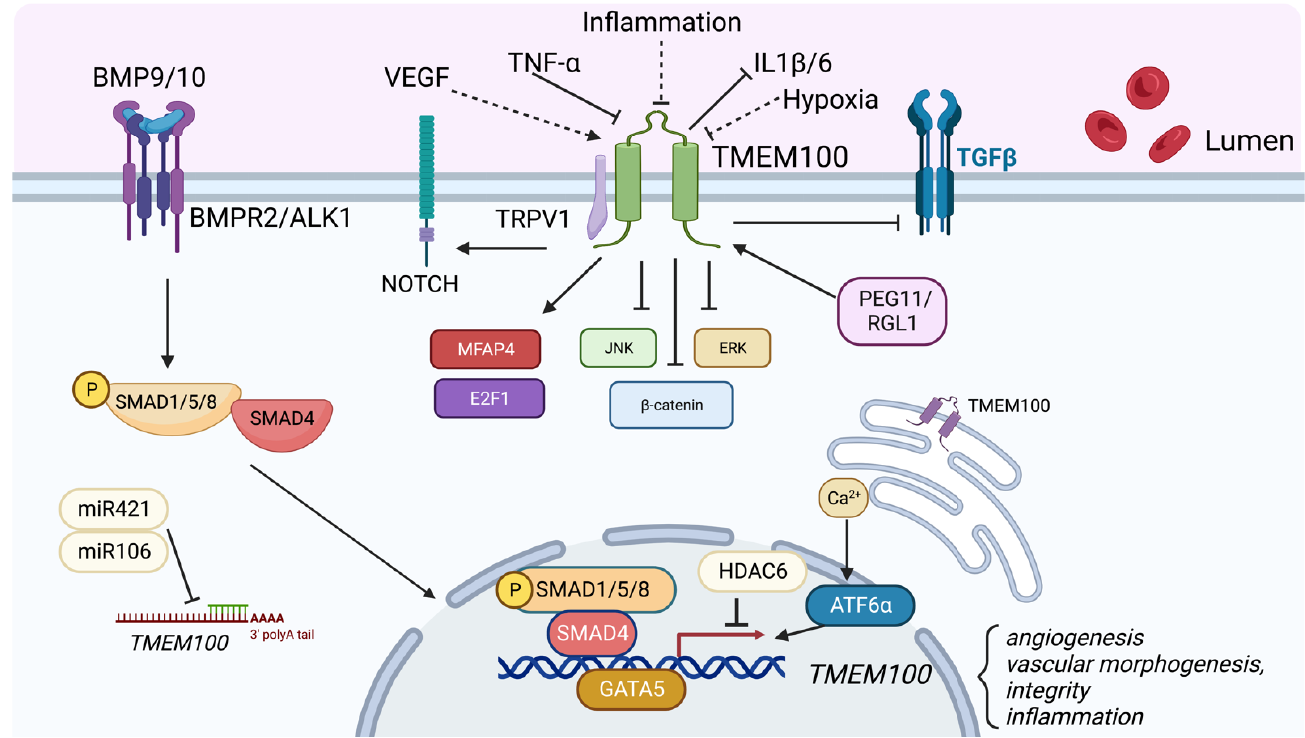
Figure 2. Role of TMEM100. TMEM100 is a two transmembrane protein located in the plasma membrane and endoplasmic reticulum membrane. TMEM100 is a BMP9/10-BMPR2/ALK1-pSMAD1/5/8 signaling downstream target. Various factors such as VEGF, PEG11/RGL1, GATA5, Calcium signaling and ATF6 𝛼 upregulate TMEM100 expression. Inflammatory cytokines such as TNF- 𝛼 , miR421/miR106, and HDAC6 suppress TMEM100 expression. TMEM100 has been demonstrated to positively regulate NOTCH, MFAP4, and E2F1 signaling, and inhibit JNK/ERK, 𝛽 -catenin, TGF- 𝛽 signaling. Our unpublished data showed that hypoxia and inflammatory injury reduce TMEM100 expression in the lung ECs, whereas VEGF upregulates TMEM100 expression. (indicated by dotted lines).